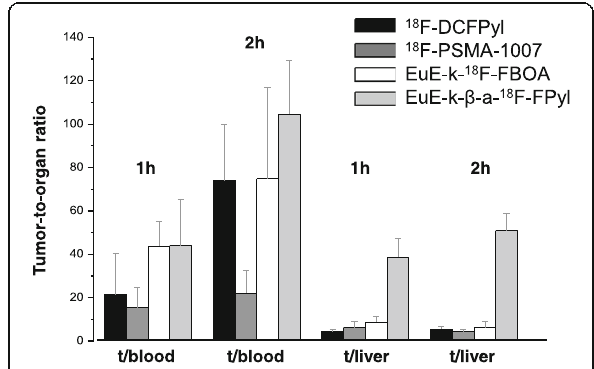
Fig. 5 Tumor-to-organ ratios for EuE-k- 18 F-FBOA and EuE-k- β -a- 18 F- FPyl in comparison to 18 F-DCFPyl and 18 F-PSMA-1007 in LNCaP- tumor-bearing SCID mice at 1 and 2 h